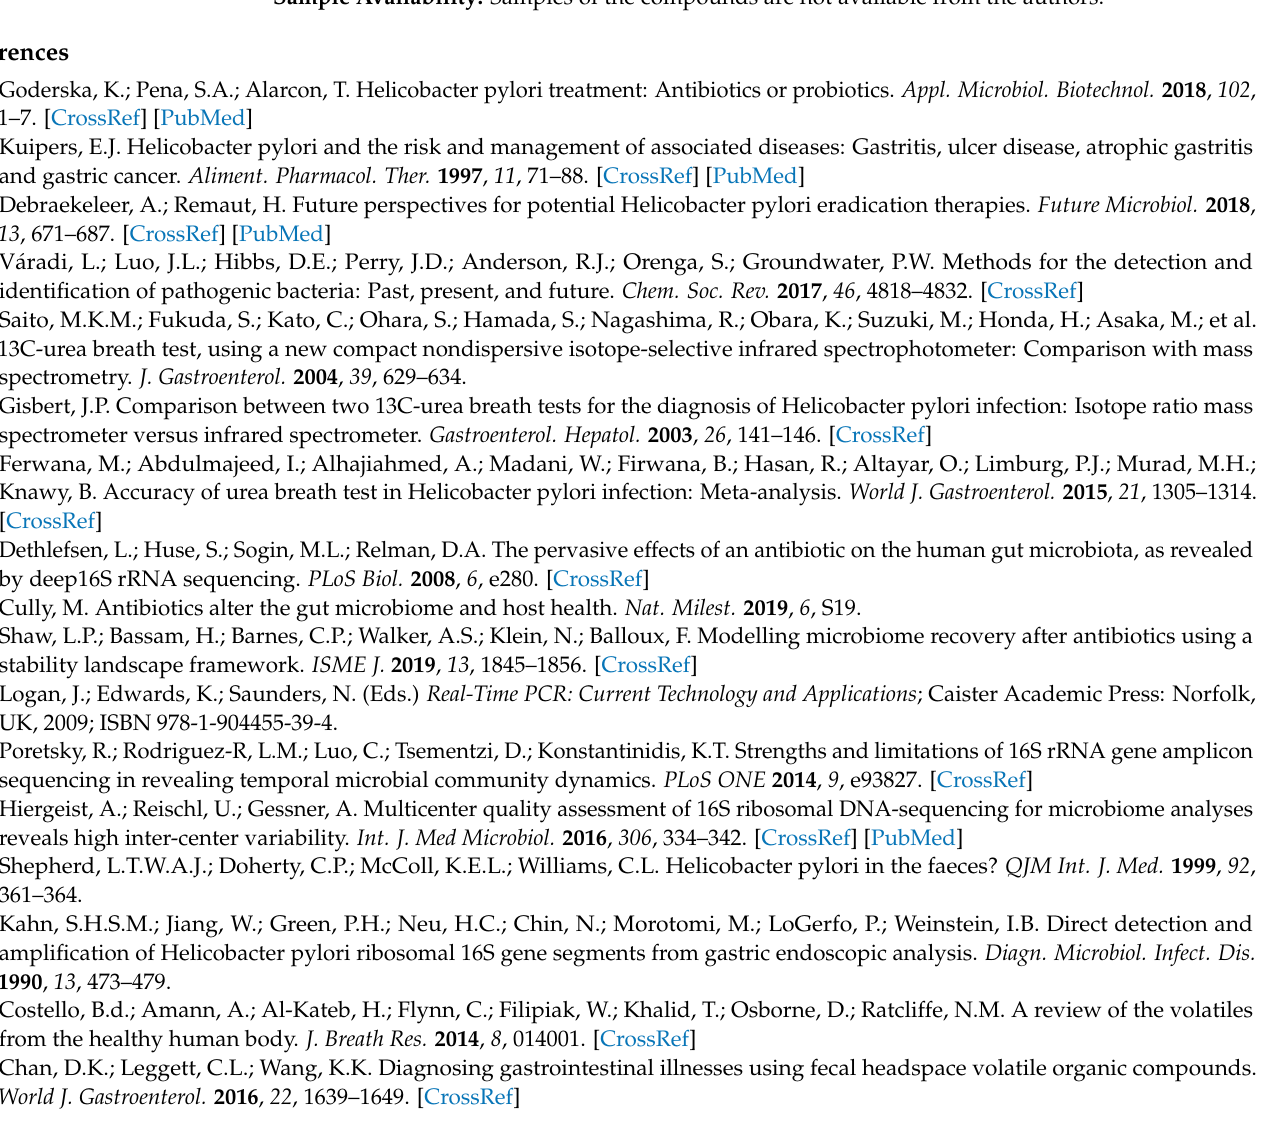
Supplementary Materials: Figure S1: Left: measured 1/noise vs square root of number of scans. Right: measured 1/noise vs spectral resolution in cm − 1, Figure S2: Working hypothesis of trans- portation of methyl butyrate and ethyl pyruvate in the body, with their release via exhaled air in lungs. References [40–60] are cited in the